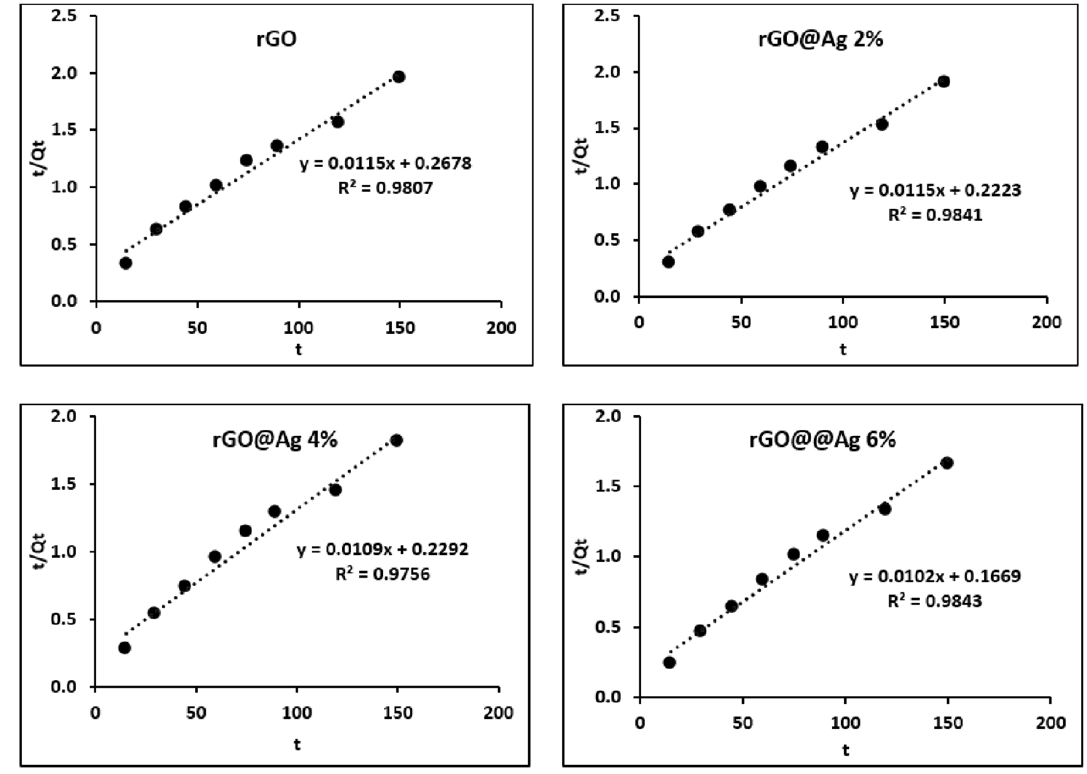
Fig. 15 Graph of the pseudo-second-order reaction for CR dye degradation using as-synthesized rGO and rGO@Ag x nanocomposites